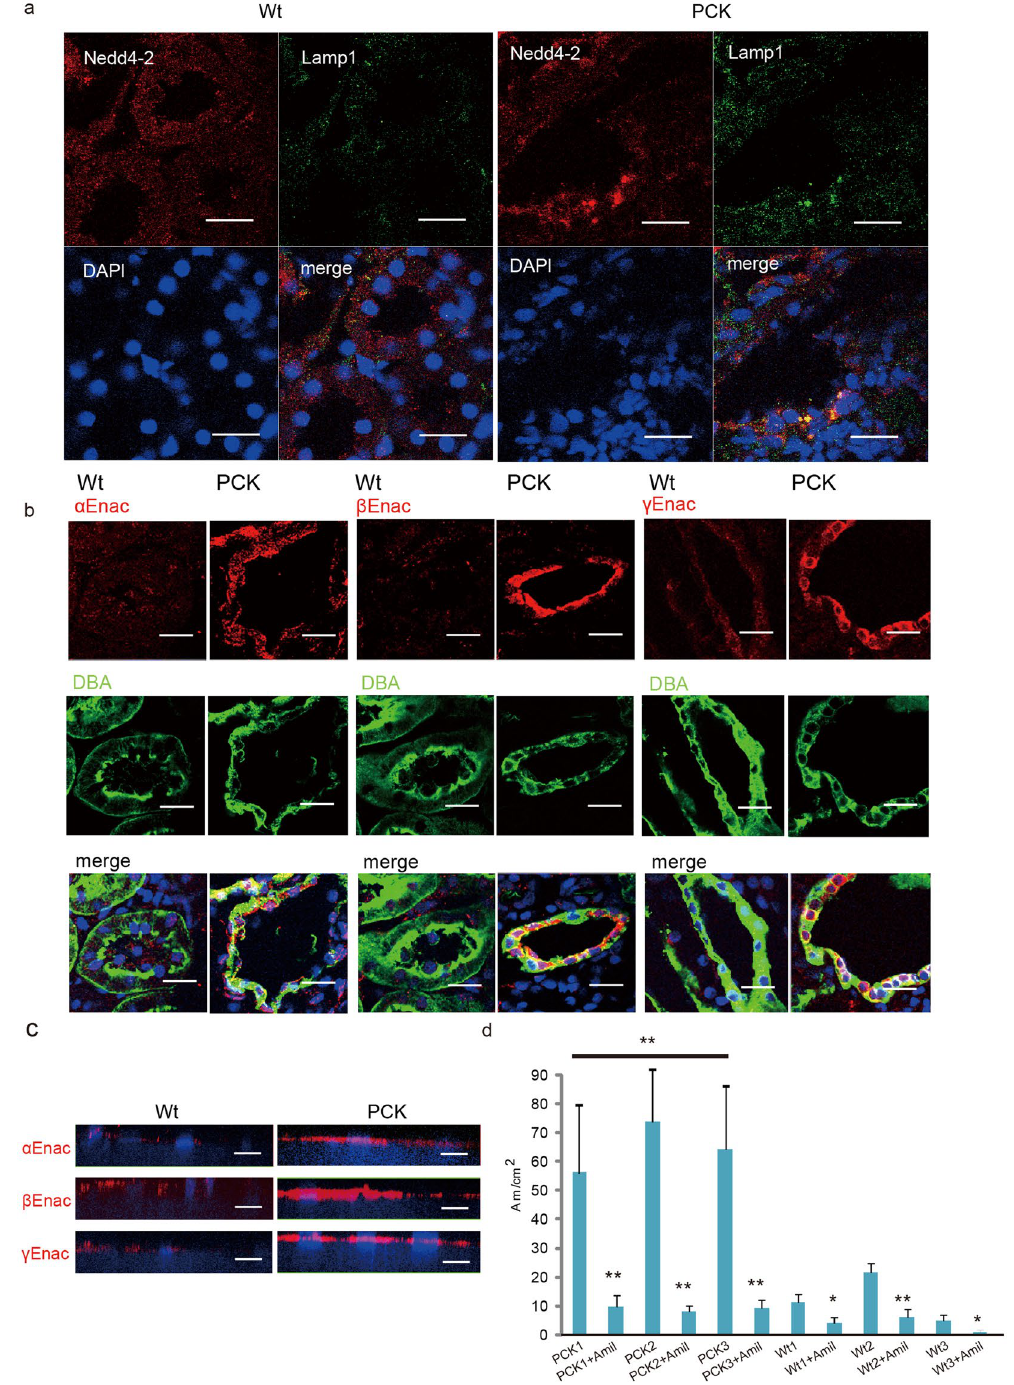
Figure 4. Nedd4-2 mis-localization in PCK kidney is associated with increased apical ENaC and enhanced sodium reabsorption. ( a ) Kidneys from 12-week old strain control (Crj:CD/SD) (Wt); left) and PCK (right) rats immunostained for Nedd4-2 (red), Lamp1 (green) and DAPI (blue). Similar patterns were observed in sections from three different mutants, and abnormalities were restricted to collecting ducts. Scale bars, 20 μ m. ( b ) Kidneys from 12-week old strain control (Wt) and PCK rats immunostained for each of the three subunits of ENaC (red), DBA (green) and DAPI (blue). Scale bars, 20 μ m. ( c ) Primary CD cells from 12-week old strain control and PCK rats were isolated and cultured on Transwell filters and then immunostained for each of the three ENaC subunits (red) and DAPI (blue). Scale bars, 10 μ m. ( d ) Open-circuit measurements of primary CD cells from three 12-week old strain control rats (Wt1, Wt2 and Wt3) and three PCK rats (PCK1, PCK2, PCK3) cultured on Transwell filters either in the absence or presence (“ + Amil) of 50 μ M amiloride in the apical side. Measurements were collected from at least 10 independent wells per animal. * P < 0.05, ** P <